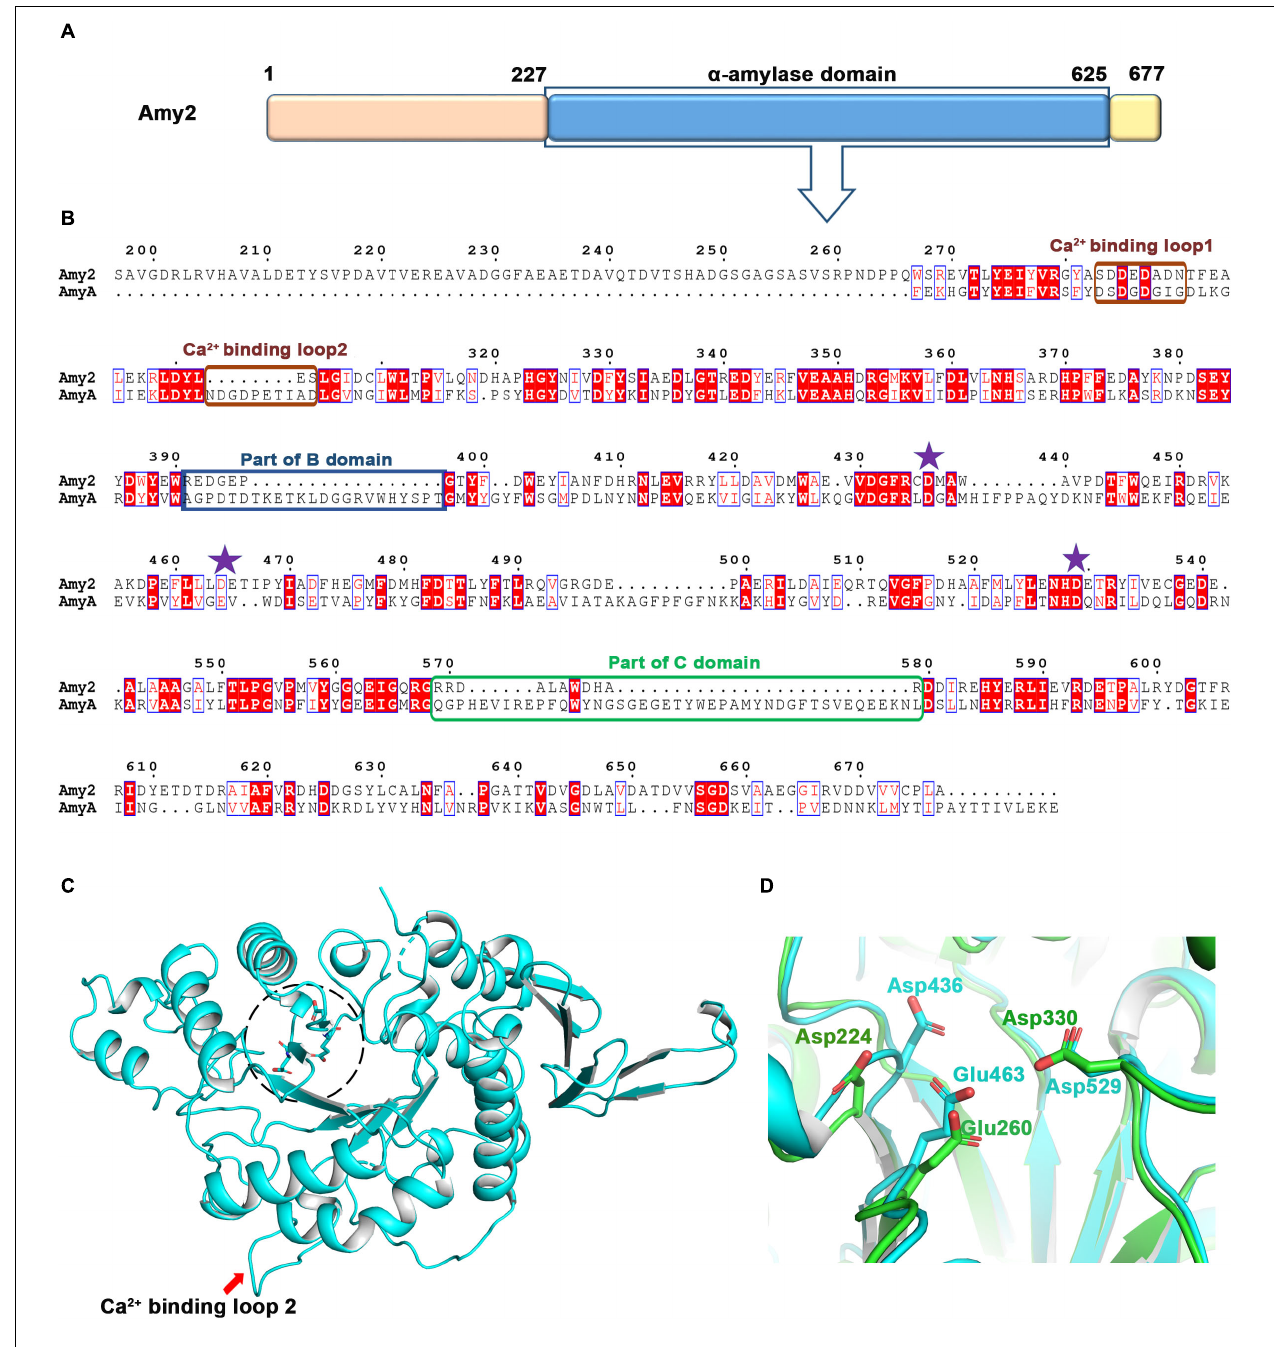
FIGURE 5 | Structural and sequence features in Amy2. (A) Schematic representation of predicted domain architecture in Amy2. The N-terminal (1–226) region, present in α -amylases from other haloarchaeal strains as well, did not show significant sequence similarity with proteins of known function. (B) Multiple sequence alignment of the Amy2 region sharing sequence conservation with H. orenii α α -amylase. The active site residues are marked in purple stars. The differences in the Ca 2 + binding loops, and domains B and C are highlighted in colored boxes. (C) Predicted structural model of Amy2 built using the PHYRE2 online web server. The active site is encircled in black broken circle and active site residues are shown in stick representation. (D) The structural alignment suggested that Amy2 (cyan) and H. orenii α -amylase (green) have conserved active site triad consisting of structurally equivalent Asp436, Glu463, and Asp529 residues.